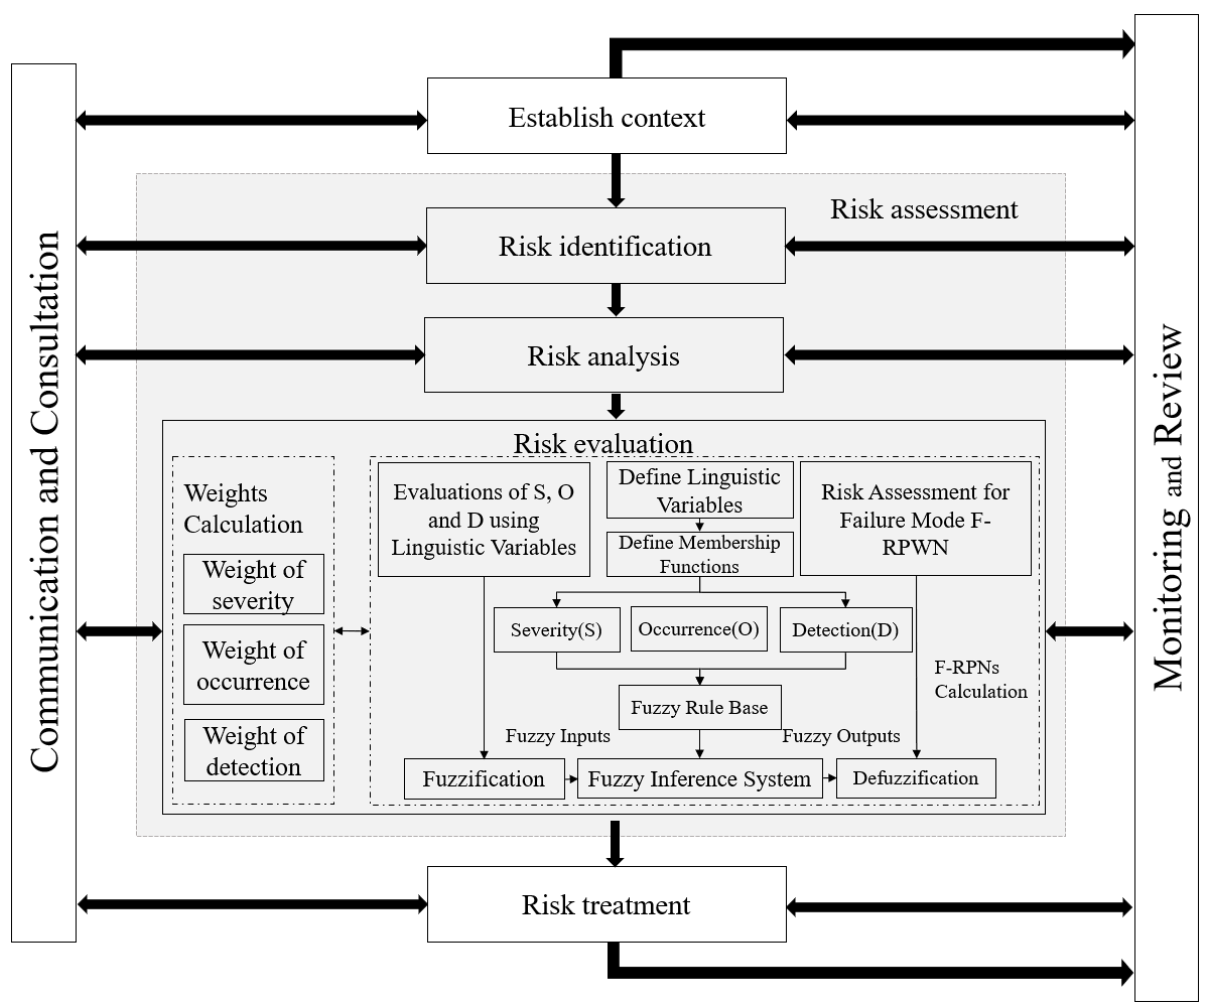
Figure 1. The procedure of implementing the proposed method.